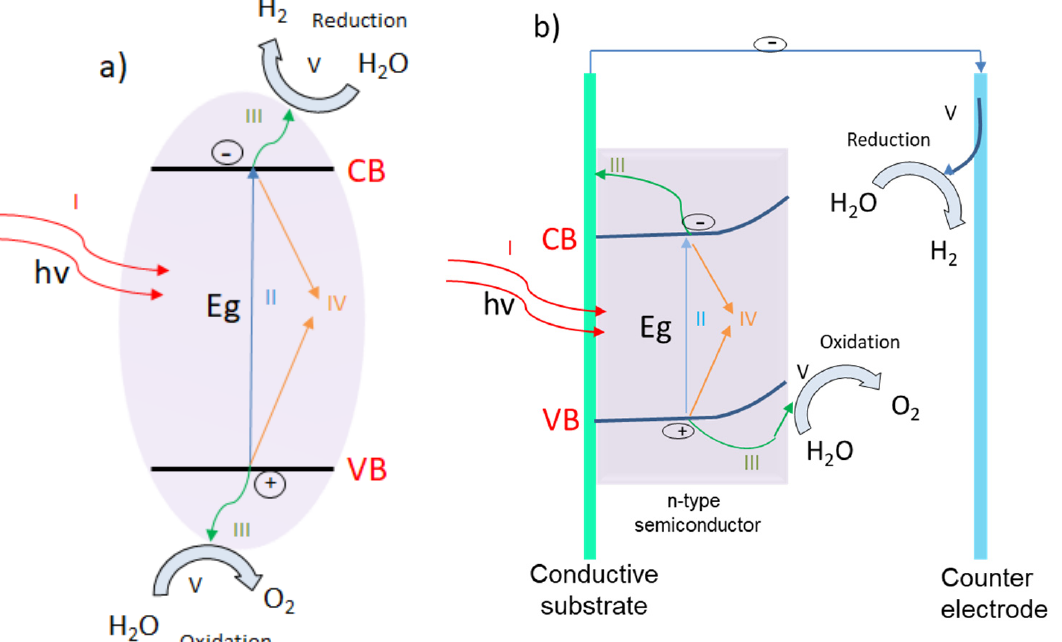
Figure 9. Schematic illustration of ( a ) photocatalytic (PC-I. Light absorption; II. Electrons jump from the valence band (VB) to the conduction band (CB); III. Redox processes; IV. Bulk recombinations) and ( b ) photoelectrochemical (PEC-I. Light absorption; II. Electrons jump from VB to CB; III. Transfer of charge carriers to the electrodes surface; IV. Bulk recombinations; V. Redox processes) processes Adapted from Ref [163].